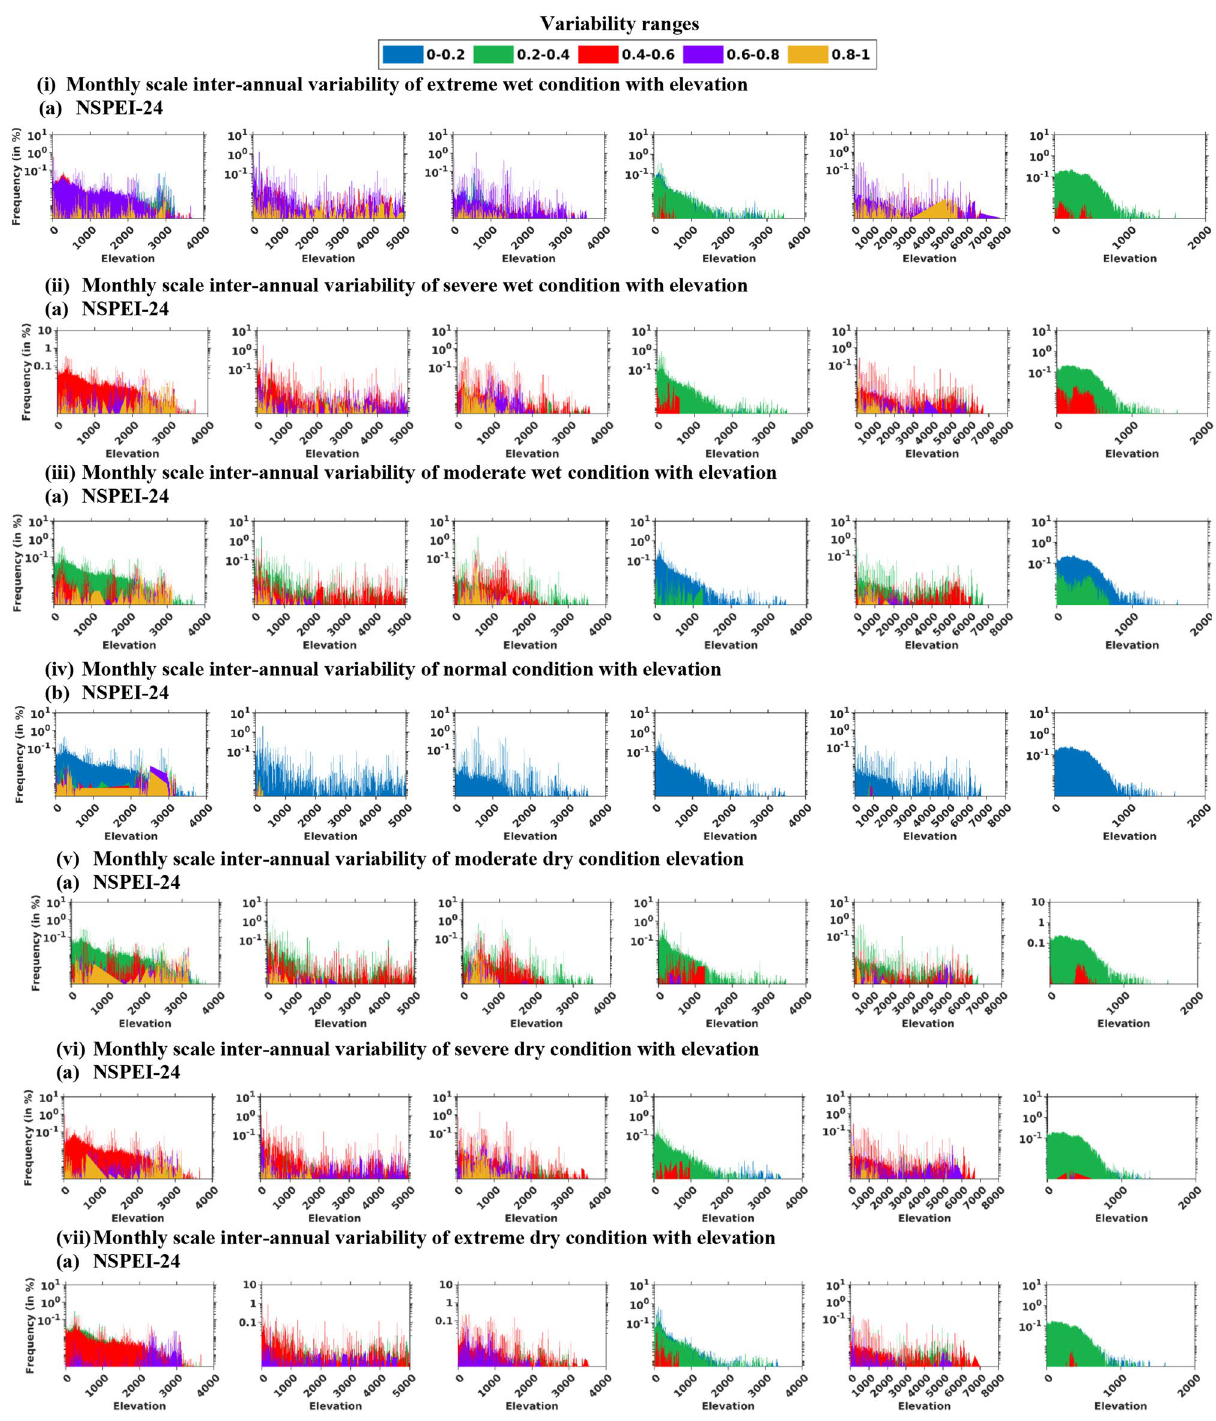
Figure 5. Monthly scale inter-annual variability (SVI AE ) in wet conditions (i, ii, iii), normal condition (iv) and dry conditions (v, vi) for different elevation ranges in various continents. In the notation NSPEI- M , M indicates the accumulation period (AP) in months. *The plots were generated using MATLAB (version: